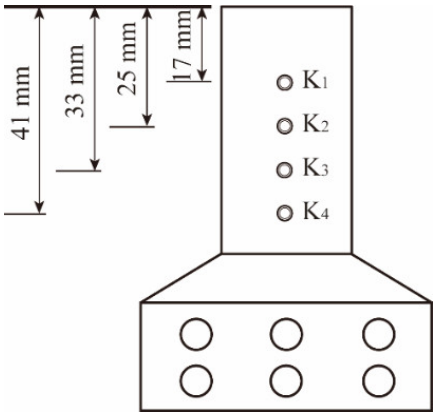
Figure 2. Schematic diagram of the vertical arrangement of thermocouples.